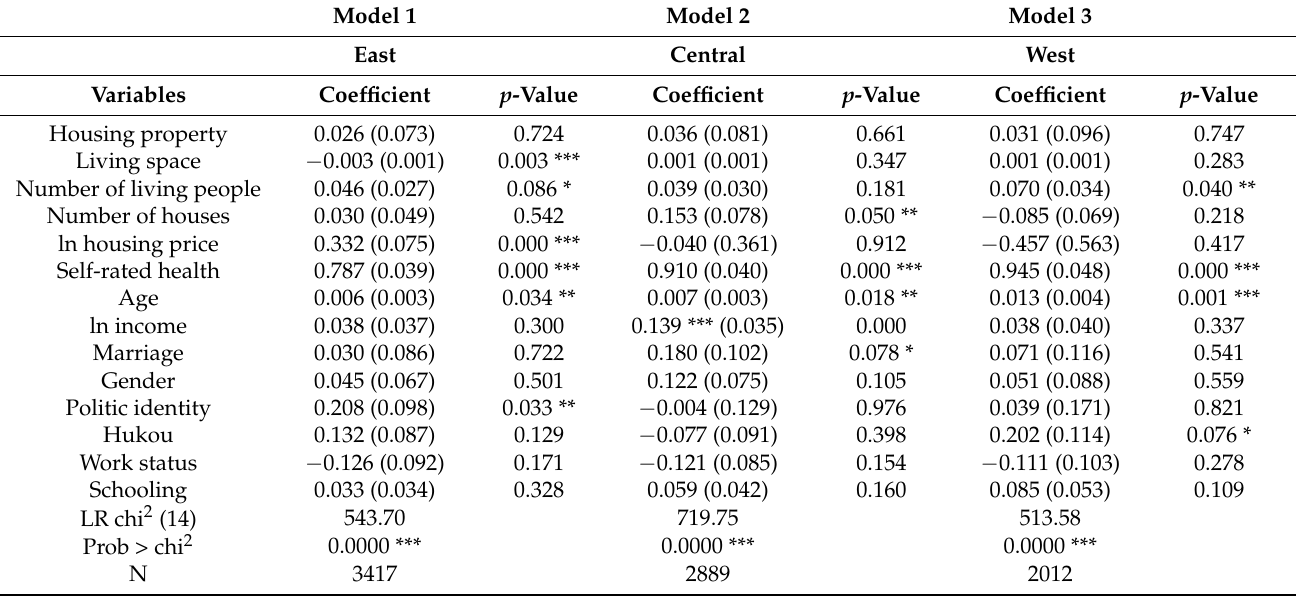
Table 4. Results for the impact of housing on mental health by region